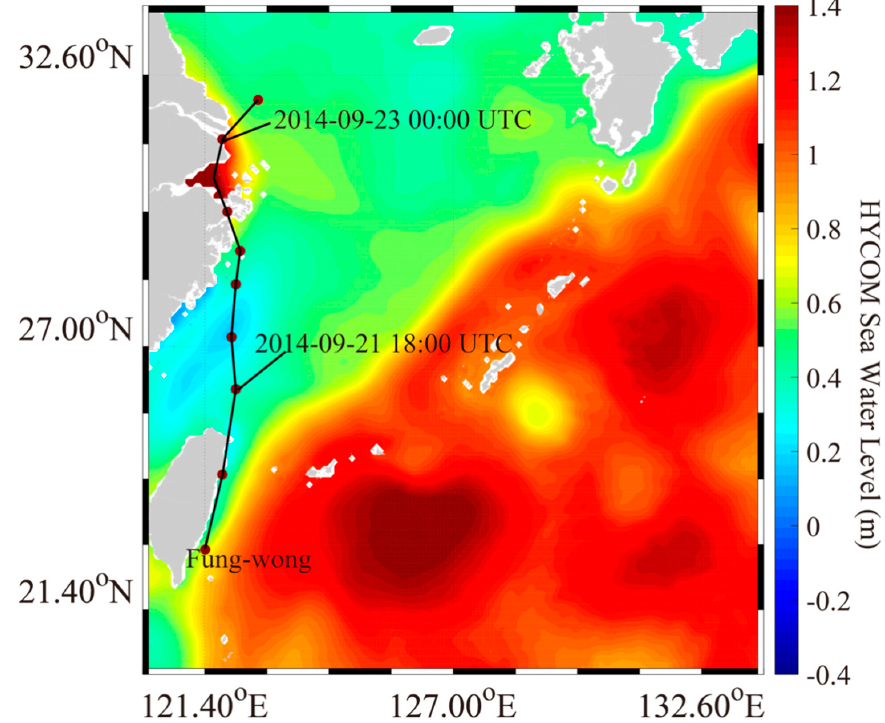
Figure 4. Sea-water-level map from the HYbrid Coordinate Ocean Model (HYCOM) at 12:00 UTC on 22 September 2014, in which the black line is the track of Typhoon Fung-wong.